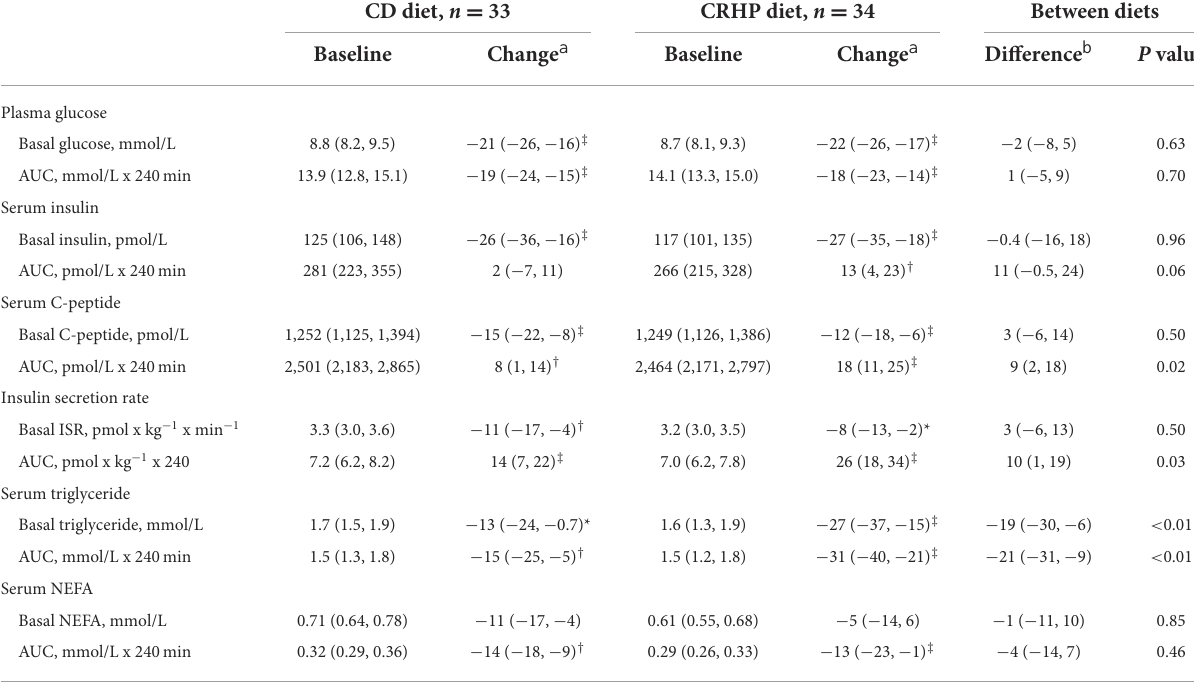
TABLE 2 Basal concentrations and responses to an oral glucose tolerance test of glucose, insulin, C-peptide, triglyceride, NEFAs, and insulin secretion at baseline and after matched ∼ 6% weight loss by a CD or a CRHP diet in individuals with T2D and overweight or obesity. CD diet, n = 33 CRHP diet, n = 34 Between diets Baseline Change a Baseline Change a Difference b P value Plasma